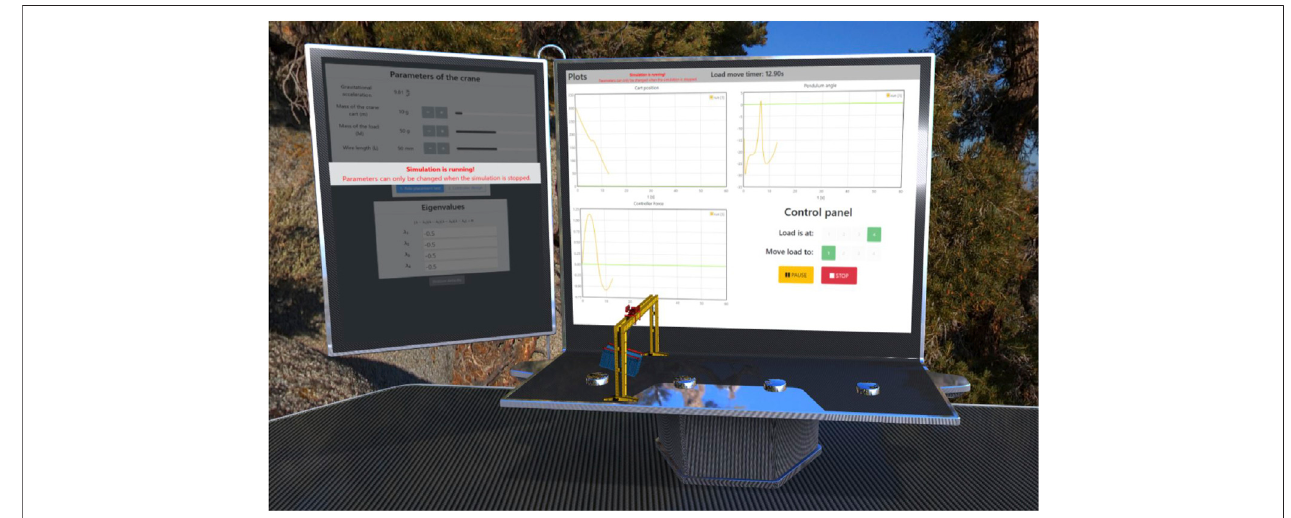
FIGURE 4 | Interactive VR learning space with 3D